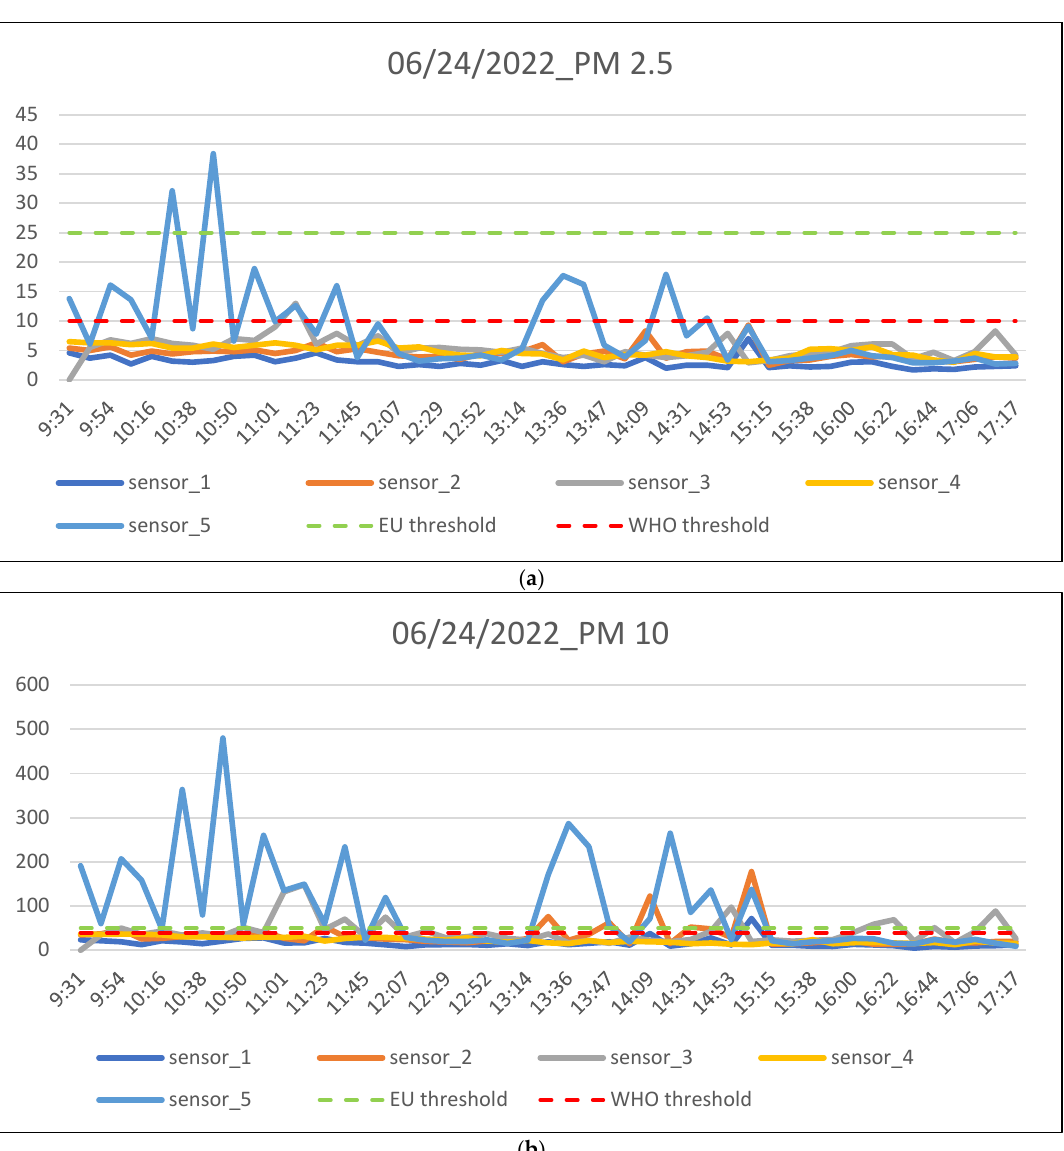
Figure 11. Result of the measurements of PM 2.5 ( a ) and PM 10 ( b ) on 24 June 2022.